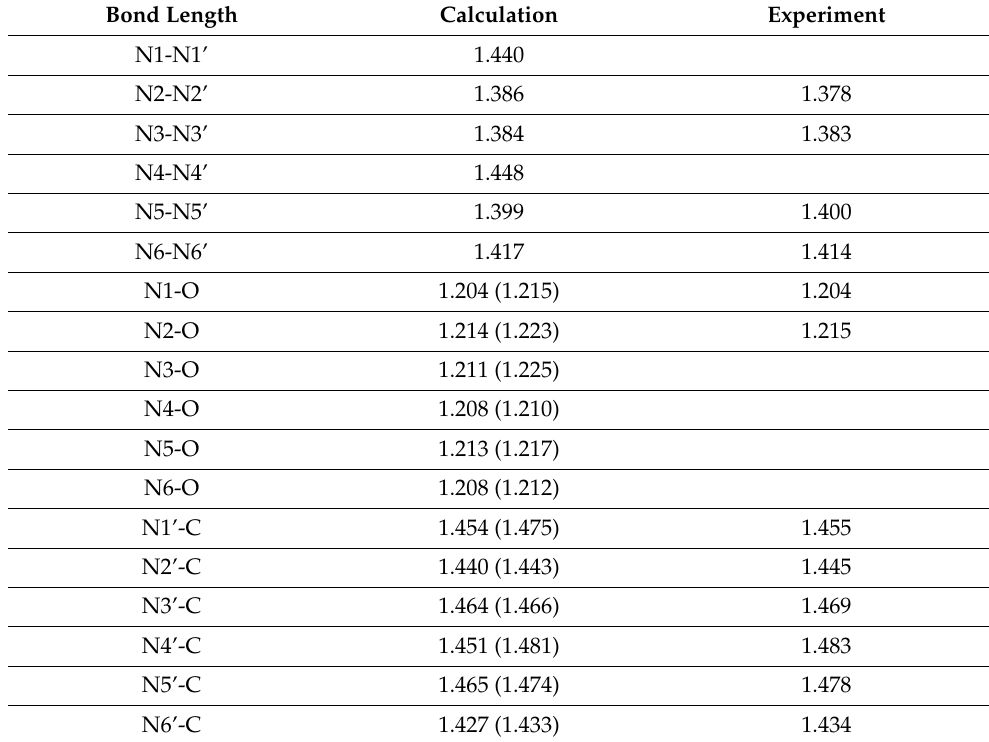
Table 1. Theoretical and experimental bond length (Å) of CL-20 in